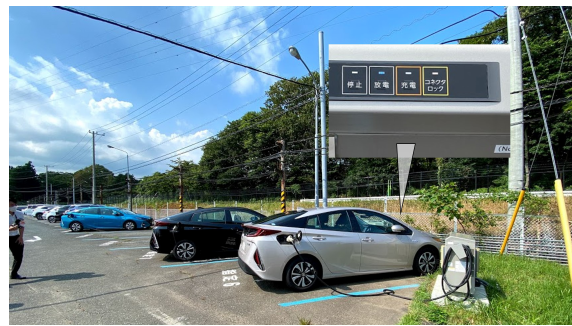
Figure 4. Birds eye view of company office participant.